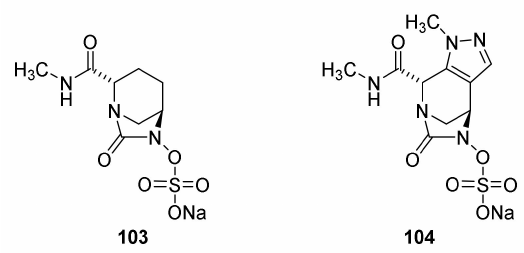
Figure 23. Avibactam ( 103 ) and NXL-105 ( 104